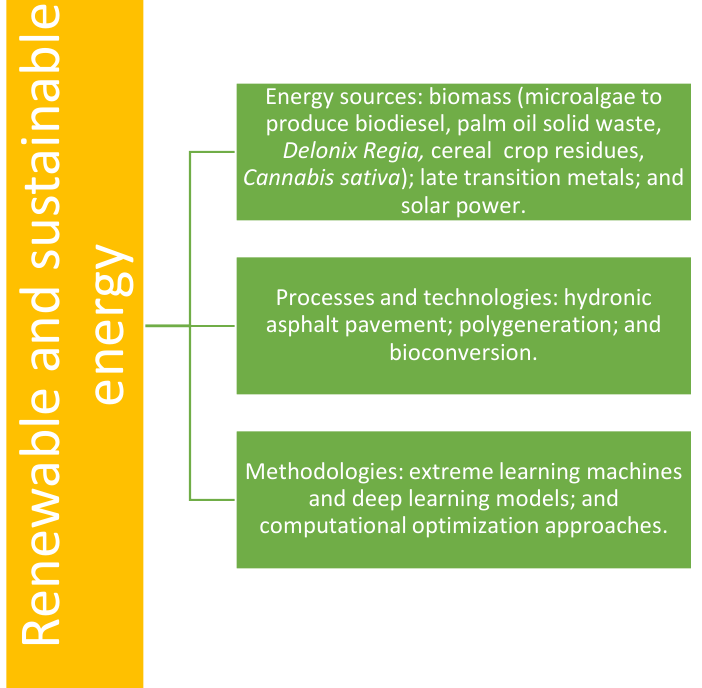
Figure 2. Topics and sub-topics related to renewable and sustainable dimensions.